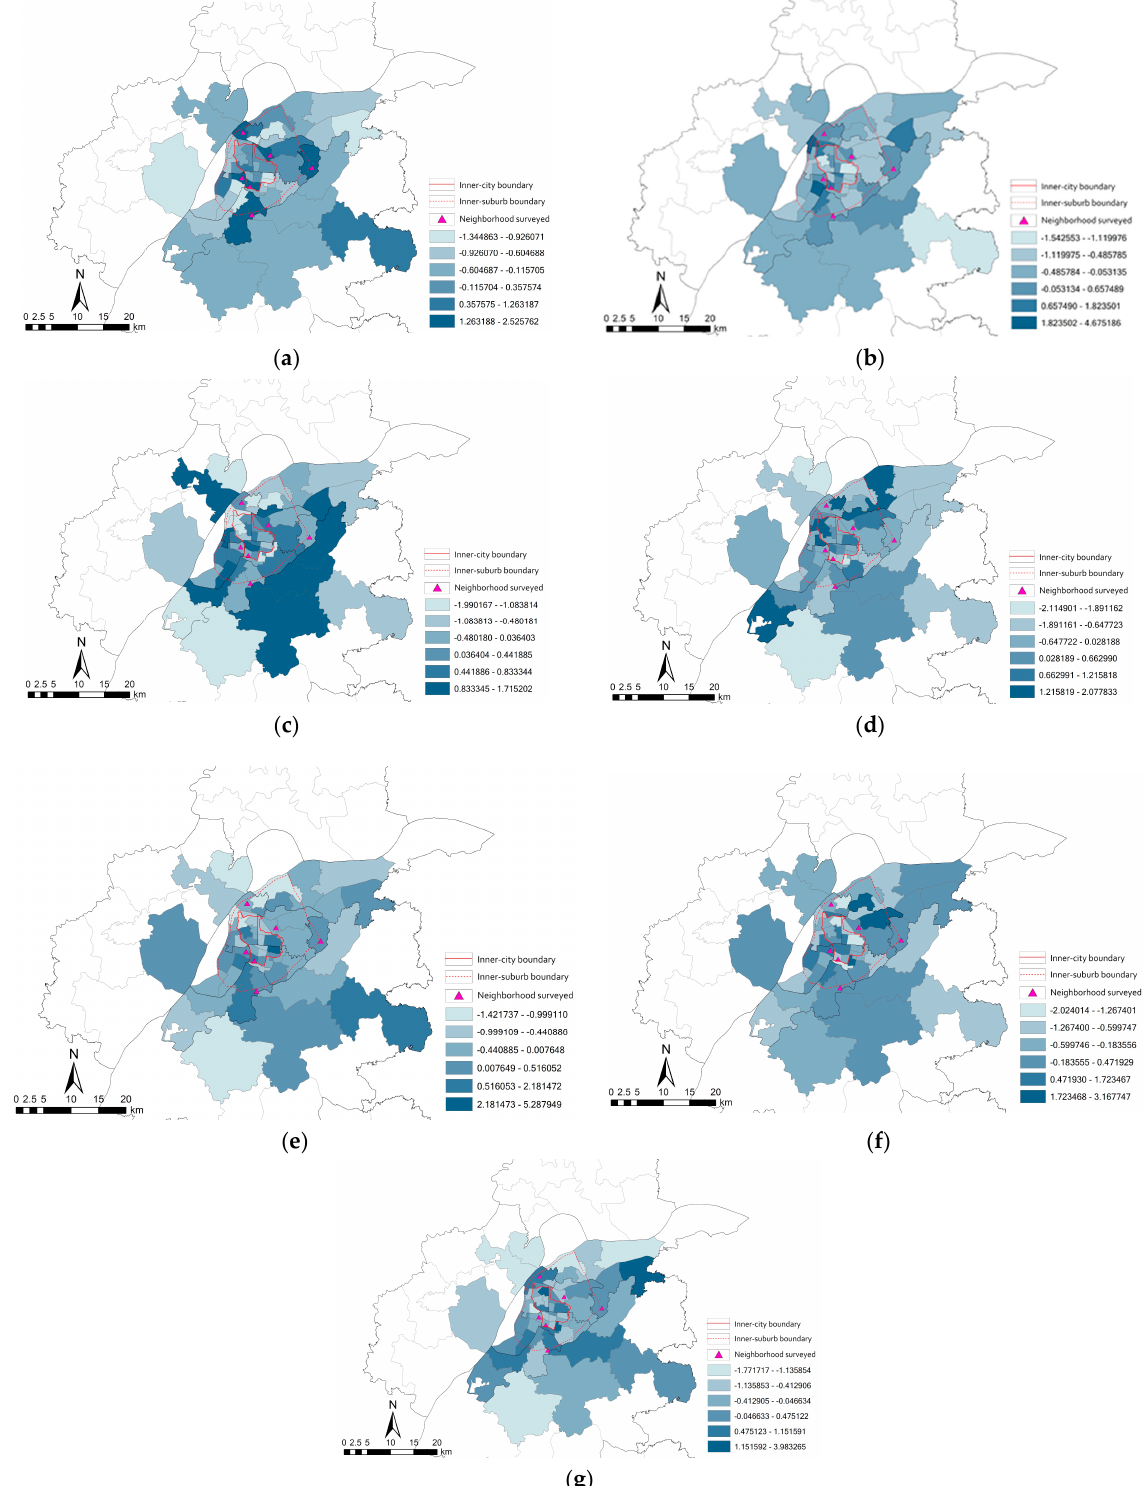
Figure 2. Spatial distribution of scores of seven main factors. ( a ) F1: Mixed leisure and low-income- other activities; ( b ) F2: Mixed shopping activities; ( c ) F3: Low-income-working activities; ( d ) F4: Non-low-income-working and leisure activities; ( e ) F5: Low-income shopping and leisure activities; ( f ) F6: Low-income other activities; ( g ) F7: Non-low-income other activities.